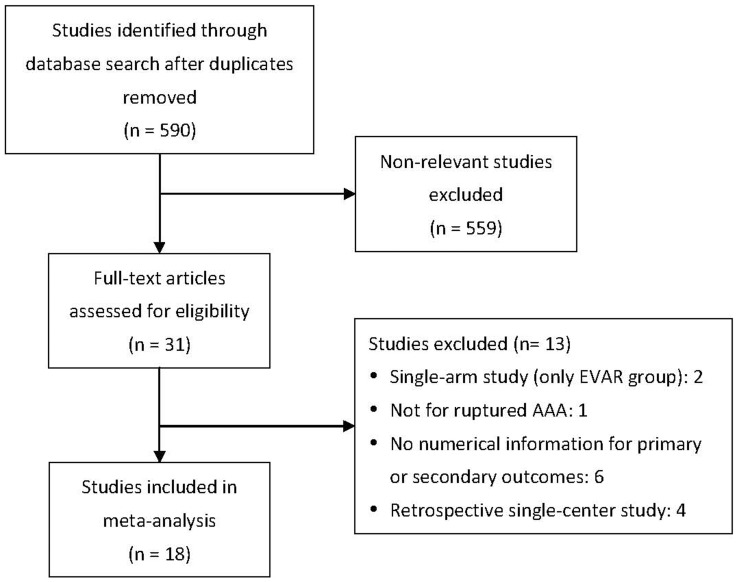
Flow chart for study selection.Abbreviation: EVAR, endovascular aneurysm repair; AAA, abdominal aortic aneurysm.